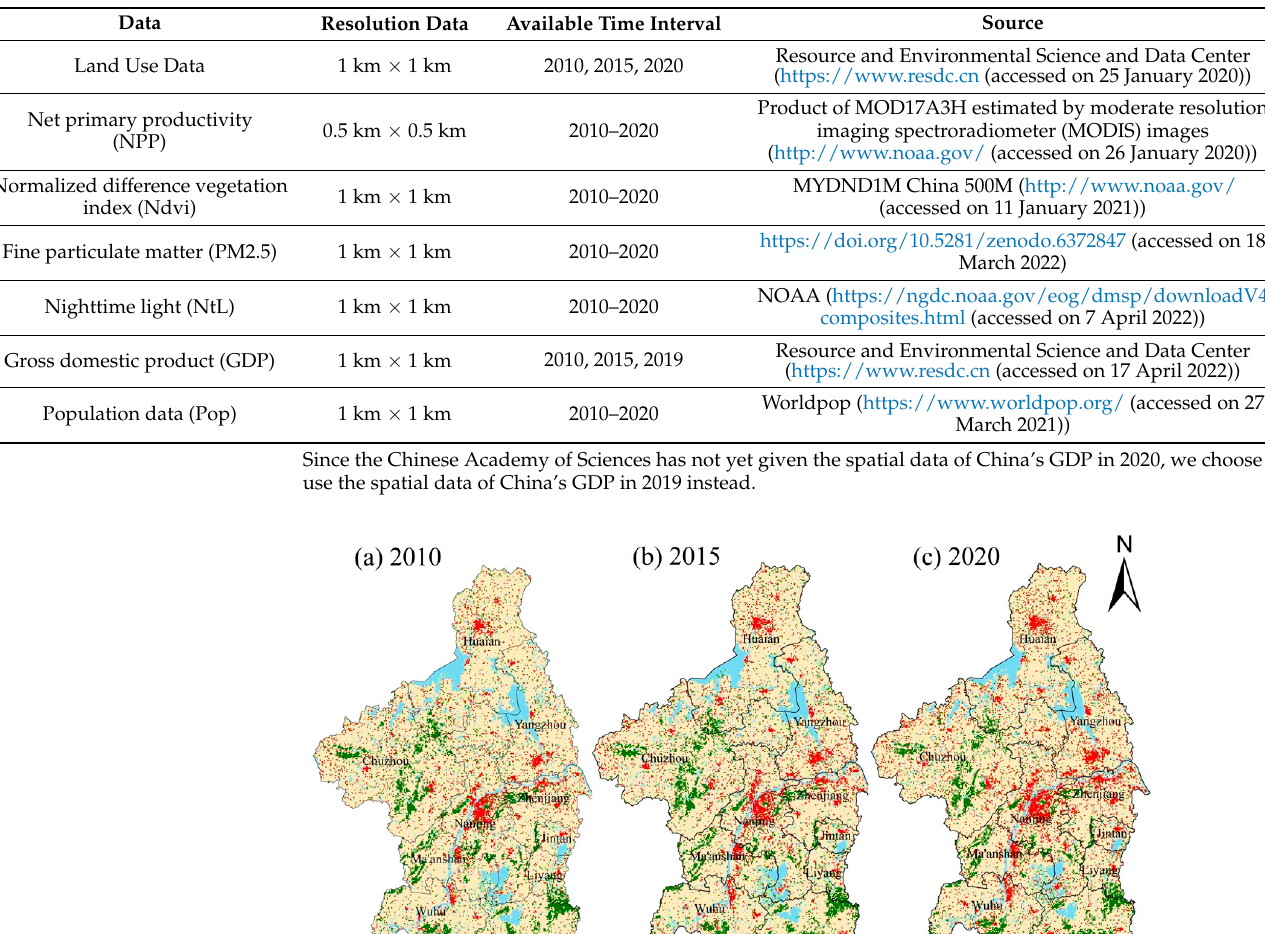
Table 1. Data sources.